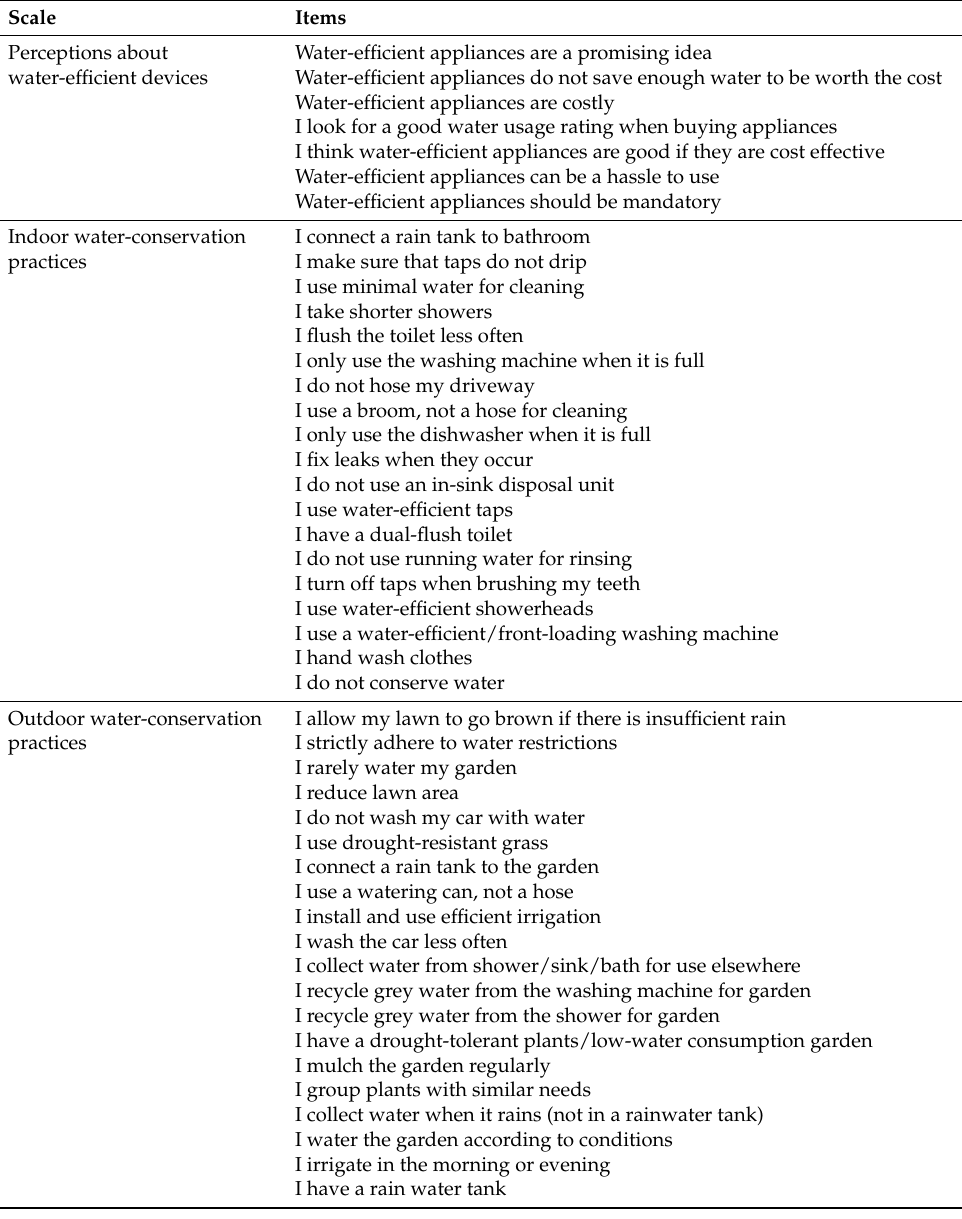
Table A3. Items used in Survey 2 assessing households’ actual water-conservation behavior. Scale